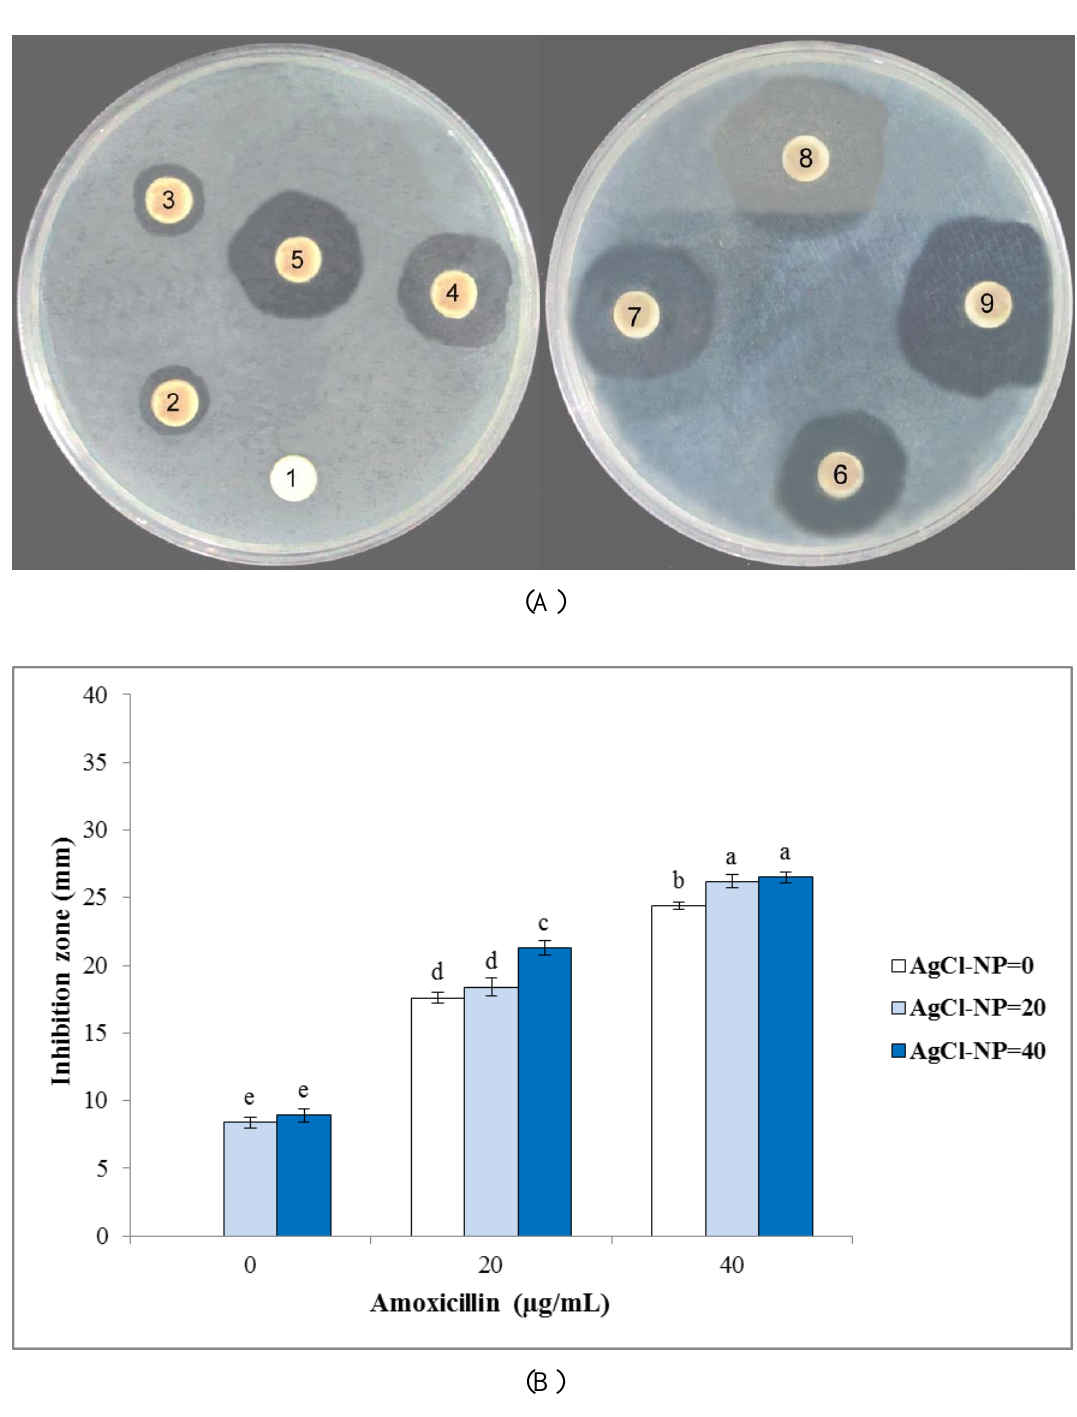
Figure 4. Antibacterial activities of biosynthesized AgCl-NPs against Escherichia coli . ( A ) Disk diffusion assay. Different disc numbers showed various concentrations of AgCl-NPs and amoxicillin, as explained in the Material and Methods section (1: control, 2: 20 µg/mL of AgCl-NPs, 3: 40 µg/mL of AgCl-NPs, 4: 20 µg/mL of amoxicillin, 5: 20 µg/mL of AgCl-NPs + 20 µg/mL of amoxicillin, 6: 40 µg/mL of AgCl-NPs + 20 µg/mL of amoxicillin, 7: 40 µg/mL of amoxicillin, 8: 20 µg/mL of AgCl-NPs + 40 µg/mL of amoxicillin, 9: 40 µg/mL of AgCl-NPs + 40 µg/mL of amoxicillin). ( B ) Inhibition zone diameter. Different letters indicate significant differences ( P < 0.05) among various treatments.